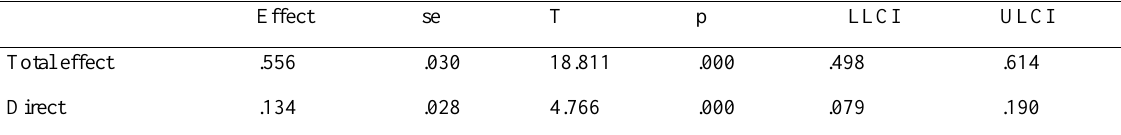
Table 8: Total and Direct effects of Entrepreneurial Course Content on Entrepreneurial Intention Effect